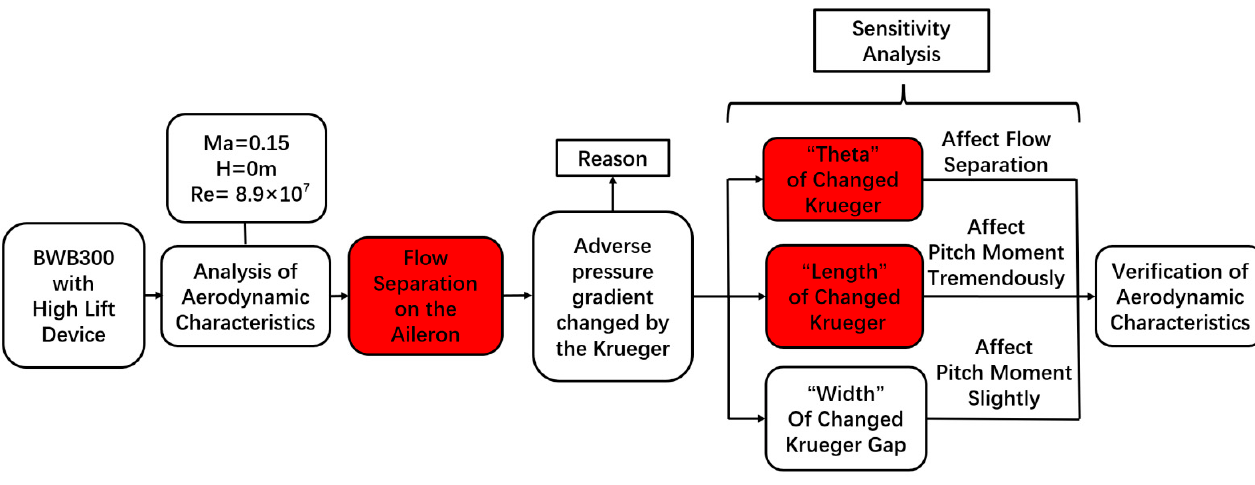
Figure 8. The entire investigation process of this